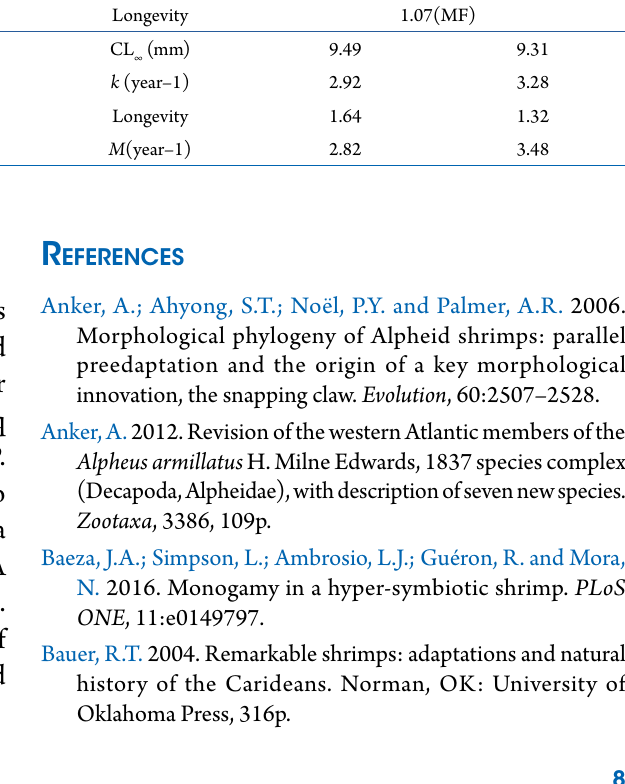
Table 2. Alpheus brasileiro Anker, 2012. Growth parameters and mortality, CL longevity and M mortality for Alpheus species. *Growth parameters with no difference between males and females, and **Growth with the difference between males and females. MF males + females. Species Reference Methods Parameter Male